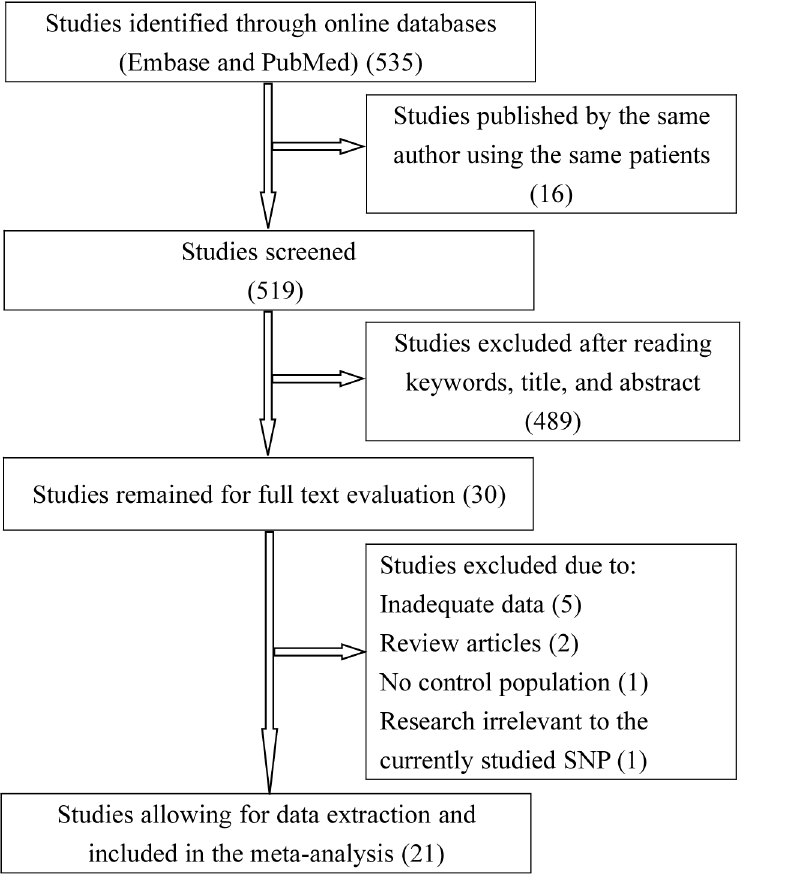
Fig 1. Flow diagram of the study selection